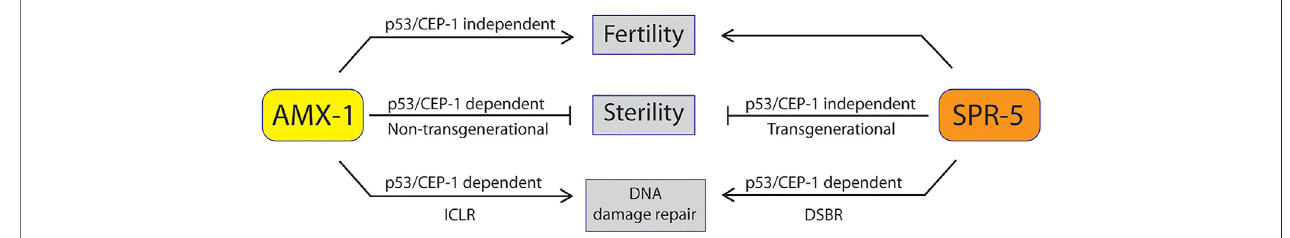
FIGURE 8 | Model of AMX-1 in sterility compared with SPR-5. AMX-1 and SPR-5 function in both redundant and non-redundant manners. In wild-type animals, bothAMX-1andSPR-5arenecessaryforproperfertilityandsterilityandmaintenanceofH3K4me2level.While spr-5 sterilitydoesnotrequirep53/CEP-1, amx-1